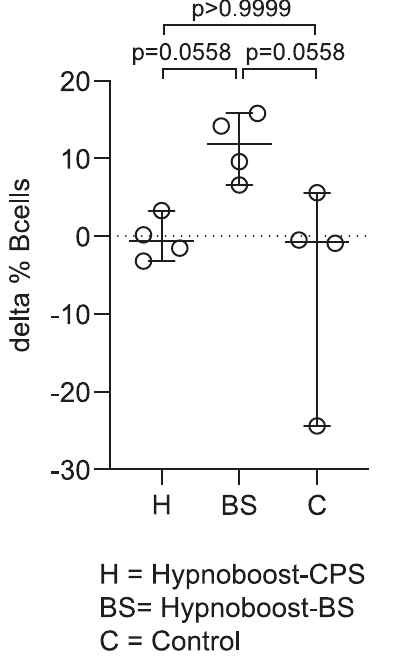
Fig. 3 Difference between the B-cell frequency at t = 0 and just before challenge for the different groups. The B-cell compartiment (CD20 + HDLA + ) was analysed using fl ow cytometry. Results of the B-cell analysis for the individual animals in the hypnoboost-CPS (H), the hypnoboost-BS (BS) and the control (C) groups are shown as difference between the relative abundance of B cells just before t-challenge and at t = 0 (while the mean B-cell abundance was 18.3% on an average of 20,000 events analysed). Horizontal lines represent group averages. Next to the median, 95% CI are also indicated. P -values (by Kruskal – Wallis) are